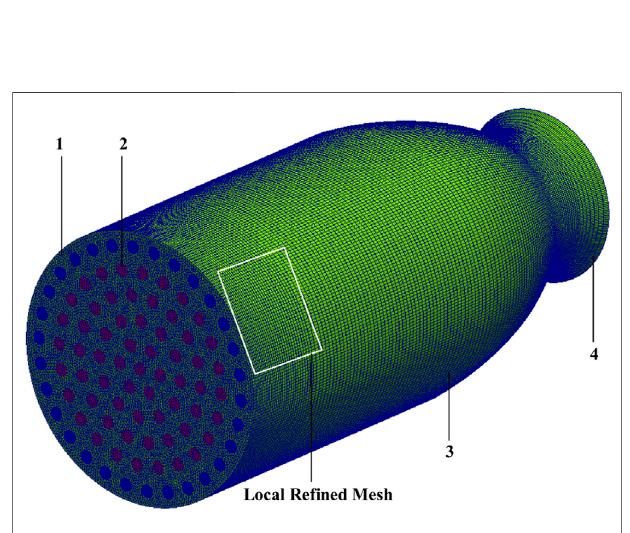
FIGURE 2 | Unstructured mesh.